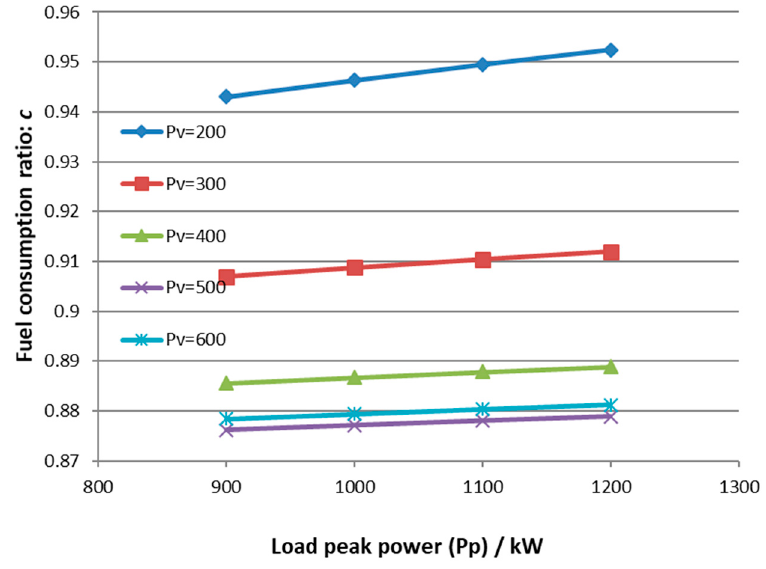
Figure 12. Fuel consumption ratio comparison ( t = 39, η = 0.85, r = r t ).